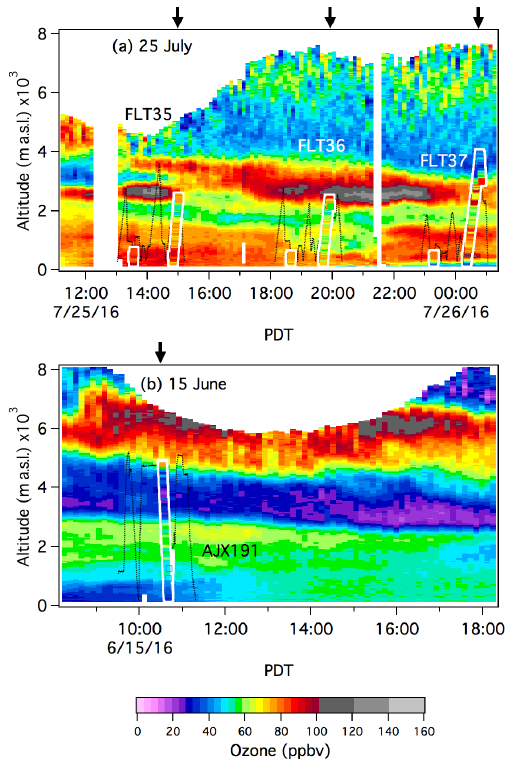
Figure 16. Time–height curtain plots of the TOPAZ ozone mea- surements from (a) 25 to 26 July with the Scientific Aviation pro- files from FLT35, FLT36, and FLT37 superimposed and (b) 15 June with the coincident AJAX profile superimposed. The aircraft mea- surements made within 5km of VMA (arrows) are highlighted by squares and colorized using the same scale as the TOPAZ data. The high O 3 layers around 3kma.s.l. in (a) are related to the Soberanes Fire; the measurements plotted in the lower right corner of (a) cor- respond to the data shown in Fig.